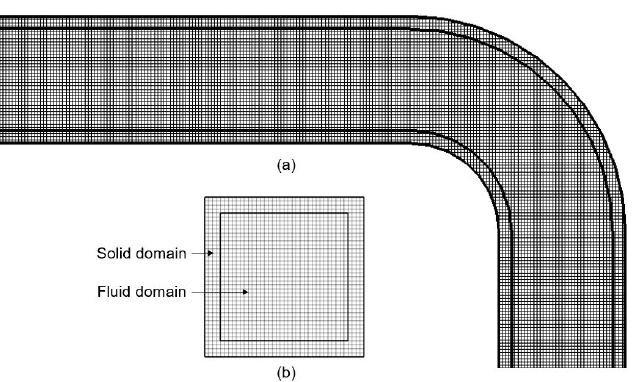
Figure 6. Computational mesh in the curved pipe. ( a ) side view, ( b ) upstream view at the cross- section [18]. section